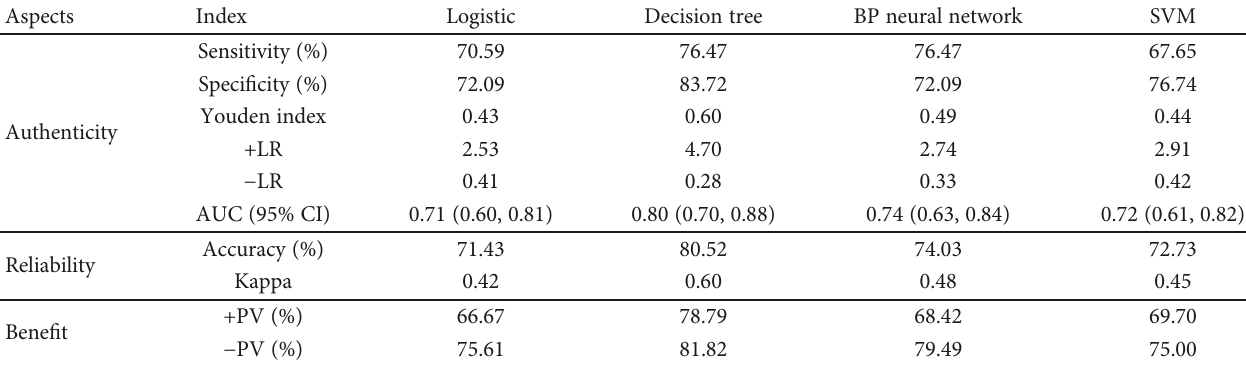
Table 7: The comparison of the test set evaluation index